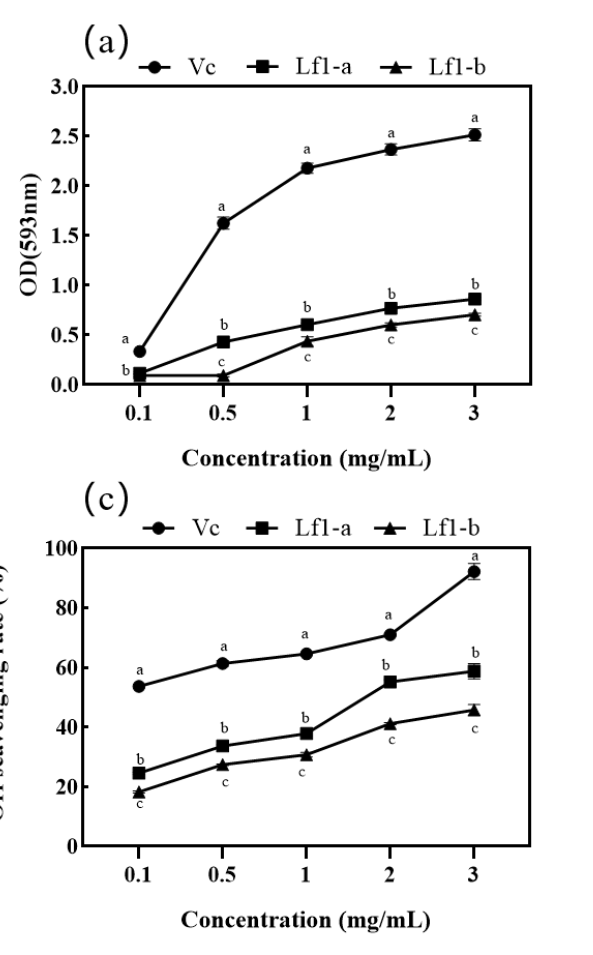
Figure 5. In vitro antioxidant capacity of Lf1-a and Lf1-b: ( a ) Reduction capacity; ( b ) DPPH scavenging activities; ( c ) Hydroxyl radical scavenging activities. Data are expressed as mean ± SD, n = 3. Values with no letters in common are significantly different ( p < 0.05).